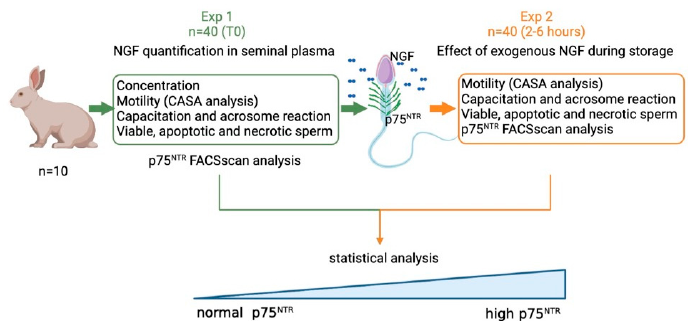
Figure 1. Operation map of experimental design applied on ejaculated sperm. In Experiment 1 (Exp. 1), sperm quality (concentration, motility, capacitation, viability) and receptor concentration have been evaluated in epididymal (n = 3) and ejaculated sperm samples (n = 40; 10 bucks × 4 experimental replicates). Based on the p75 NTR -positive cells at Time 0, the samples were categorized into two groups named Normal p75 NTR (N = p75 ≤ 25.6%) and High p75 NTR (H = p75 NTR > 25.6%). In Experiment 2 (Exp. 2), the same semen samples were divided into two aliquots: one used as control, and another added with NGF (storage times: 2–6 h), generated with Biorender.com (last accessed on 18 January